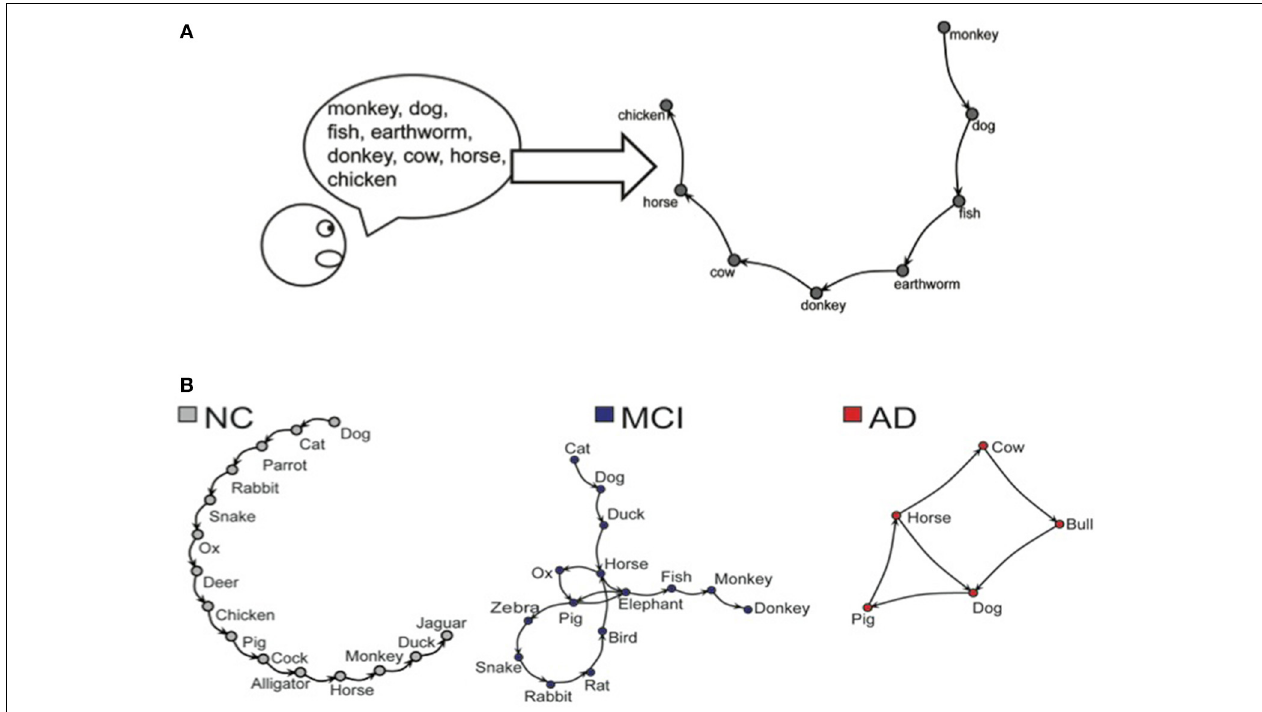
FIGURE 1 | (A) Representation of the word sequence produced on the Semantic Verbal Fluency task. (B ) Representations of networks generated by NC, MCI, and AD subjects during the Semantic Verbal Fluency